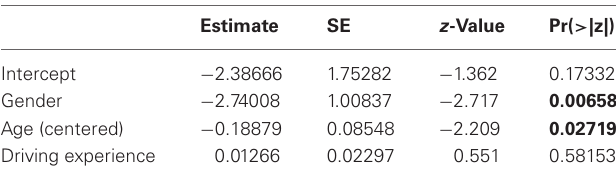
Table 2 | Logistic regression model for video game experience (significant effects in